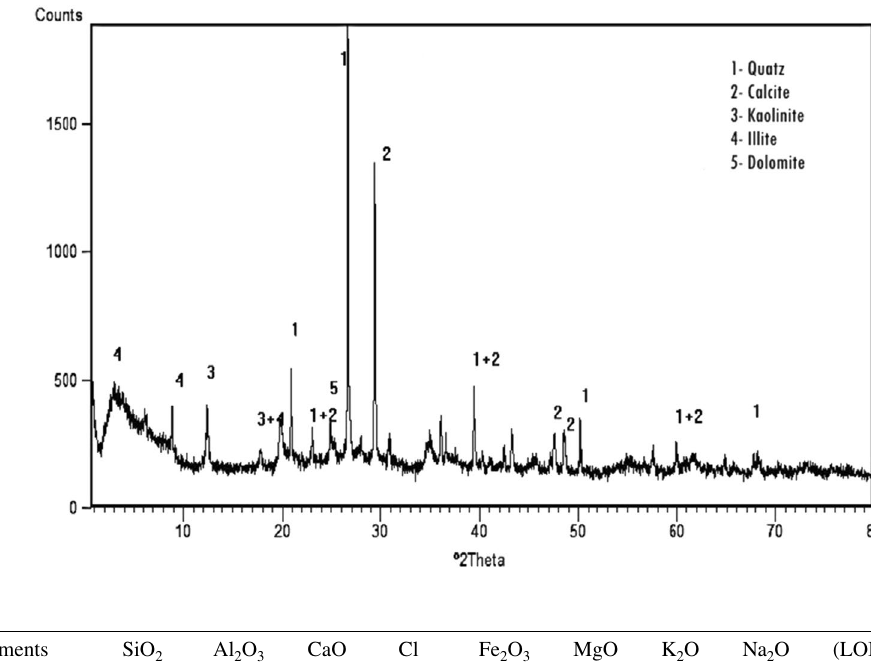
Fig. 4 X-ray diffractogram of natural mud